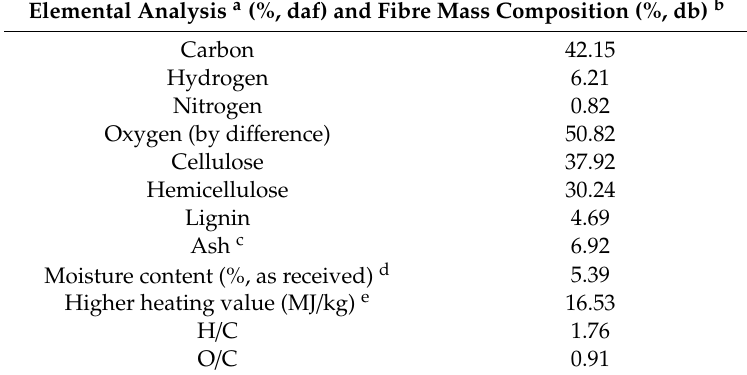
Table 1. Characterization of wheat straw used for the hydrothermal liquefaction (HTL)